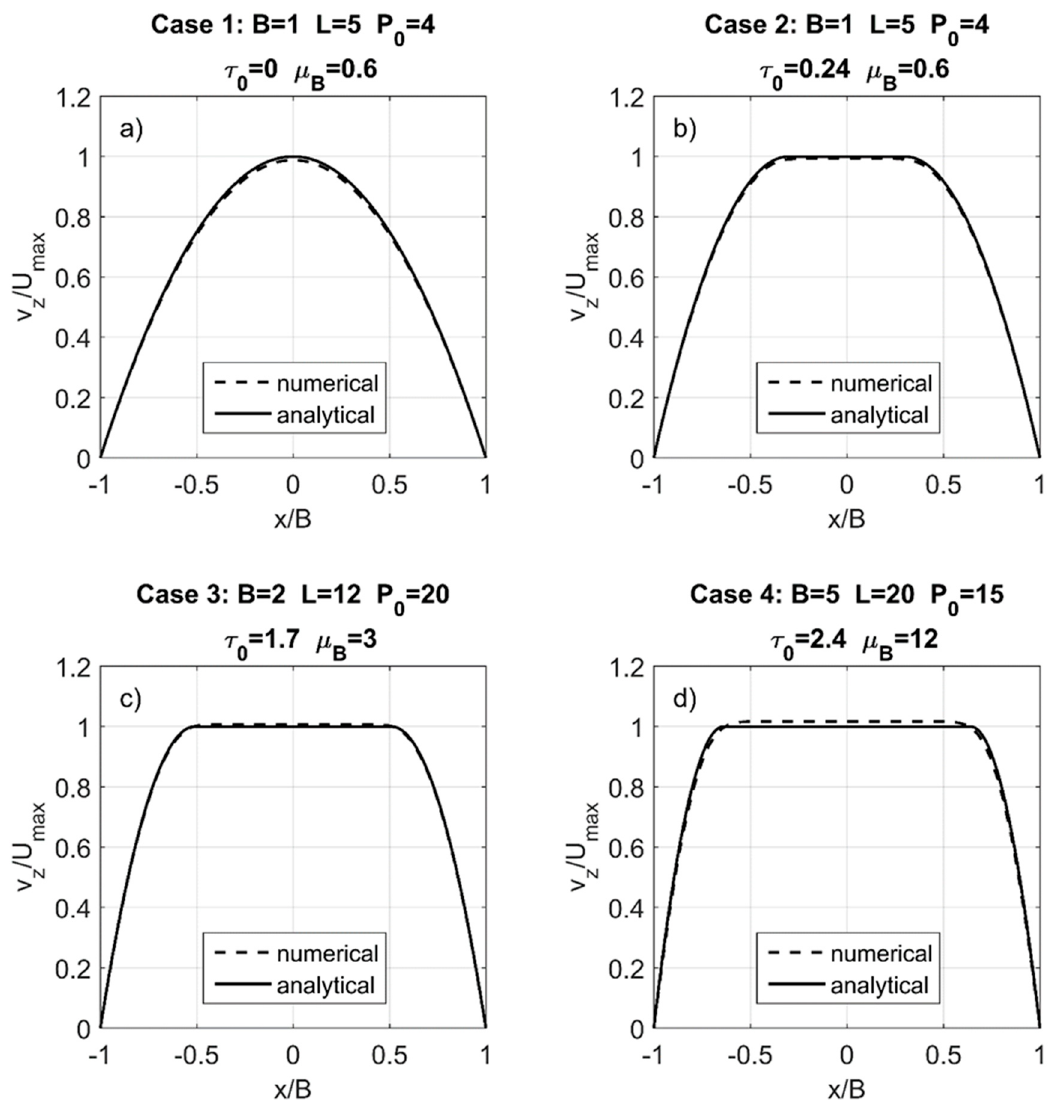
Figure 2. Validation of velocity profiles in a channel. ( a ) Newtonian fluid; ( b – d ) Bingham fluids with different parameters. The dashed lines are the numerical results. The solid lines are the analytical solution from Byron-Bird [49].